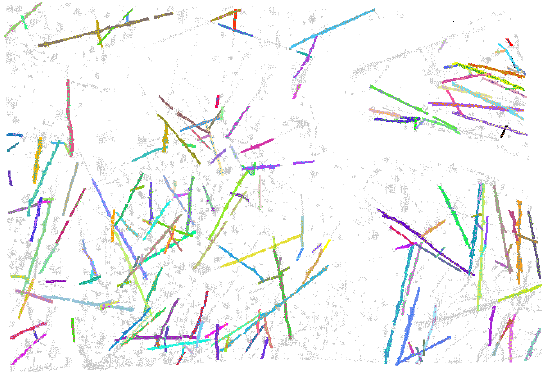
Figure 8: Segmentation result - Plot